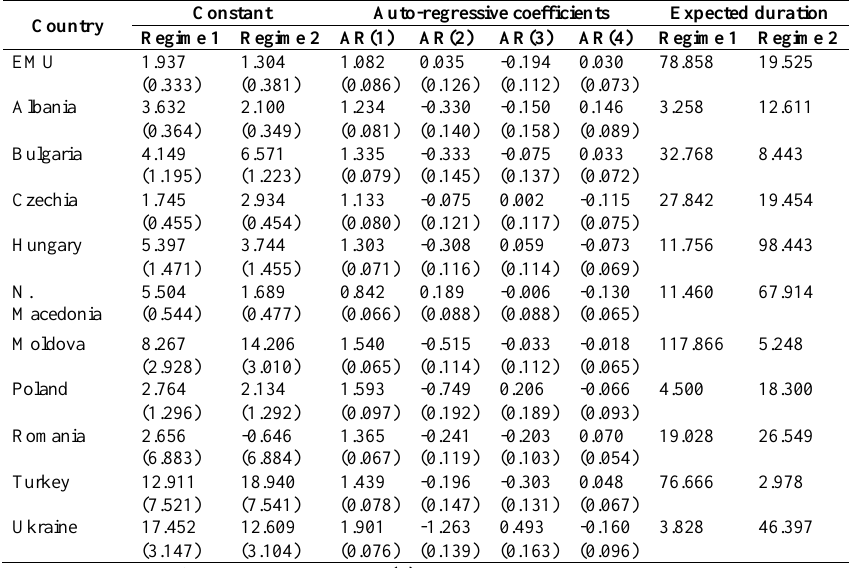
Table 1. Estimation results of Markov-switching regressions for inflation rates